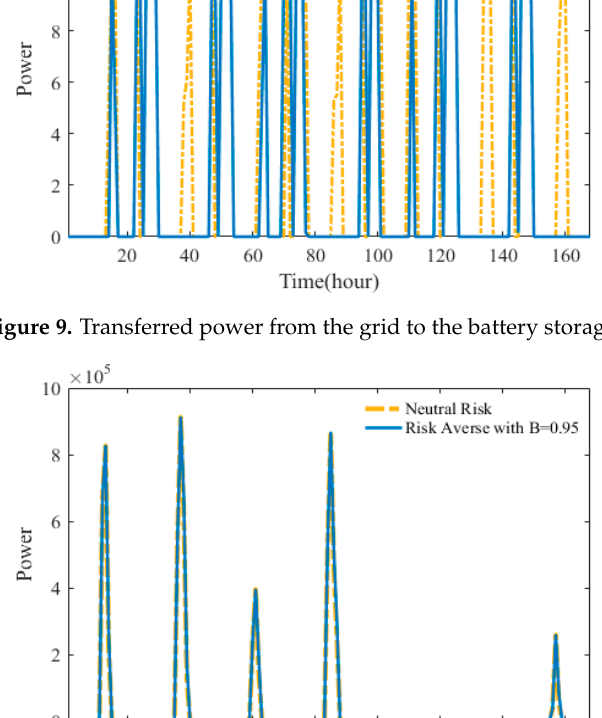
Figure 10. Transferred power from the PV to the grid.